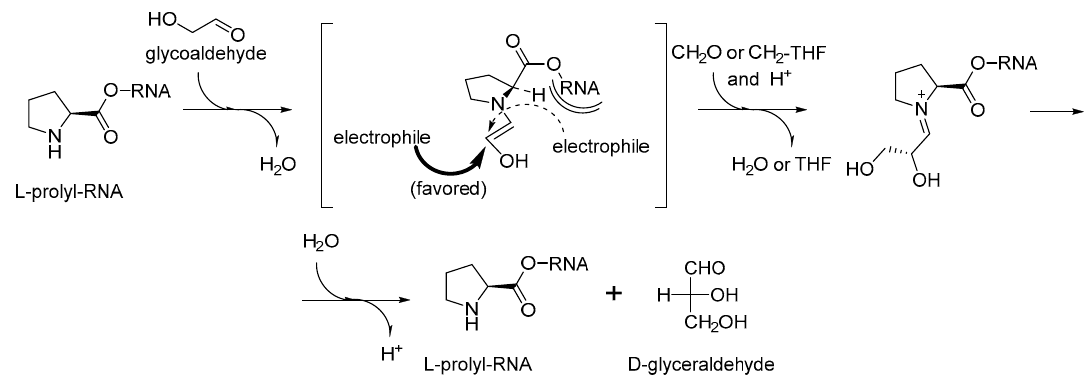
Figure 8. Possible condensation catalysis with chirality transfer on prolyl-RNA (as analogous to proline-catalyzed condensation [67,68]).